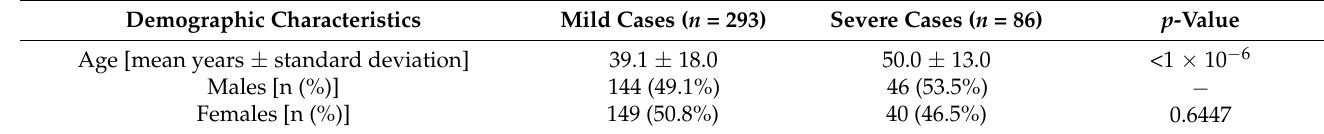
Table 1. Demographic characteristics of influenza A(H1N1)pdm09-infected patients with different grades of disease severity. Demographic